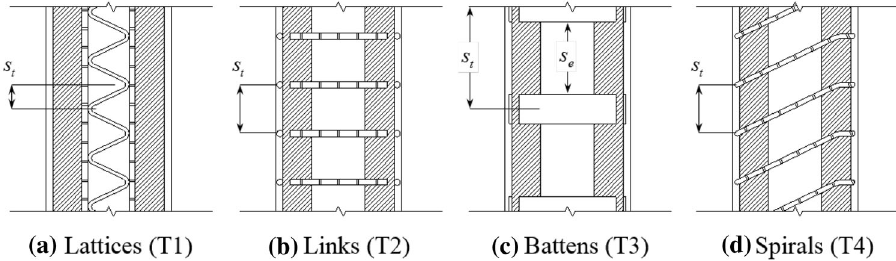
Fig. 3 Transverse reinforcement types of previous test specimens (Kim et al. 2014, 2017; Eom et al. 2014; Hwang et al. 2016).